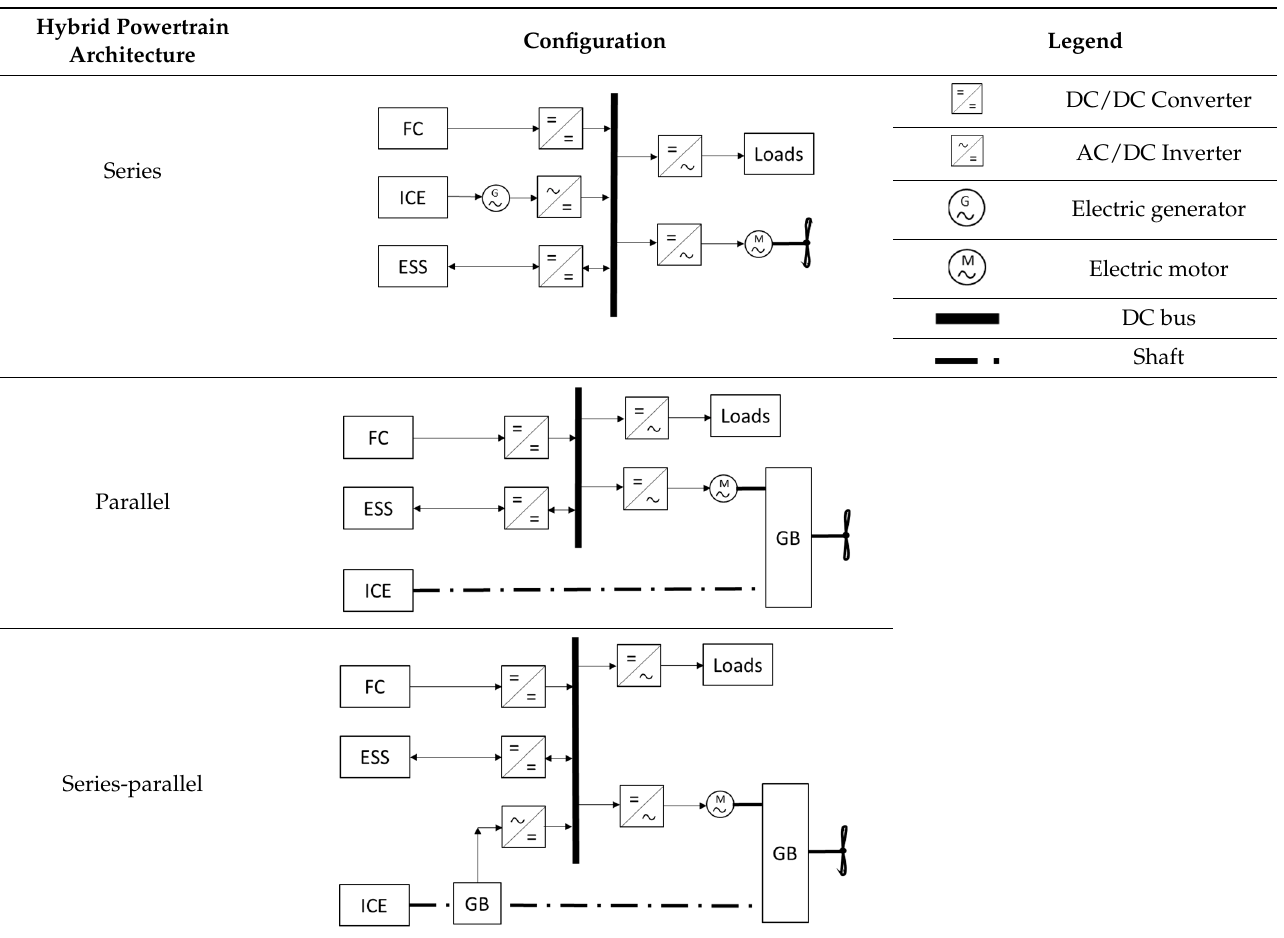
Table 3. Hybrid powertrain architectures for generation systems that include FCs and ICE. Elaborated from [24,106].